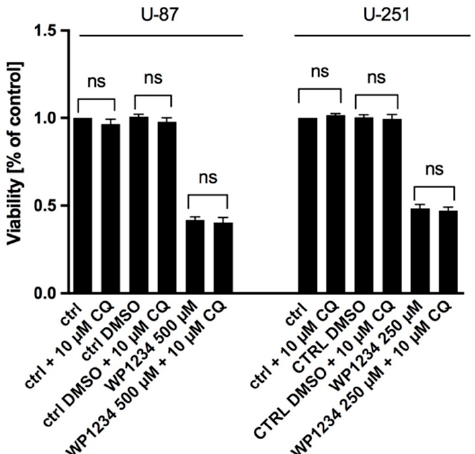
Figure 10. MTS assay showing viability of U-87 and U-251 cells after combined treatment of CQ (10 μ M) with IC 50 concentration of WP1234 for 72 h (ns—no significance).